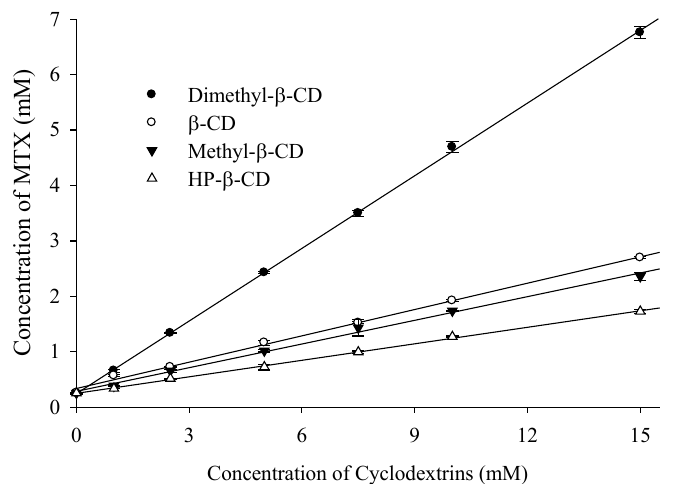
Figure 1. Phase solubility diagram of MTX as a function of different cyclodextrin concentrations ( n = 3).